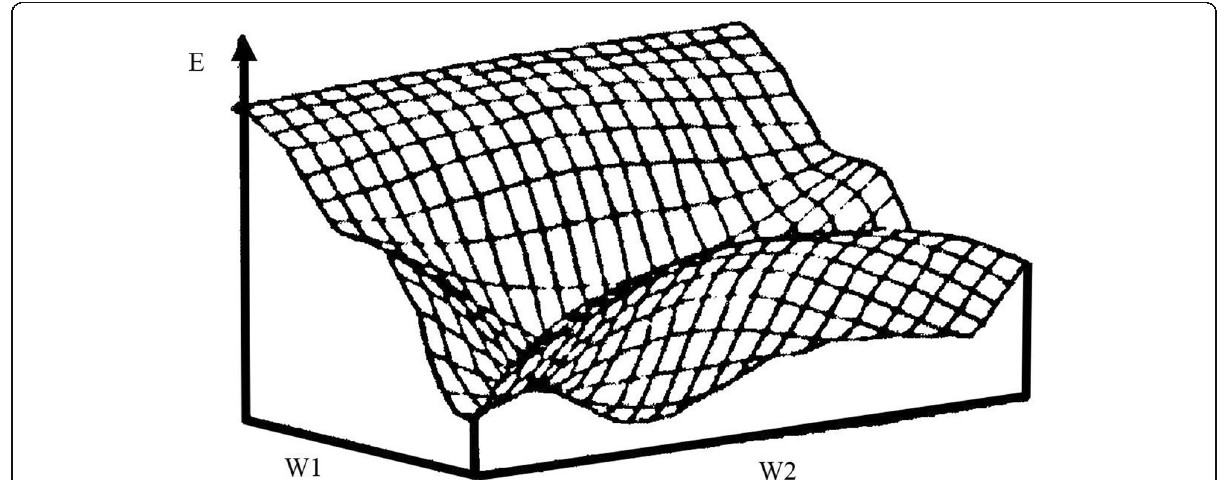
Fig. 3 The distribution of weight error in two dimensional space